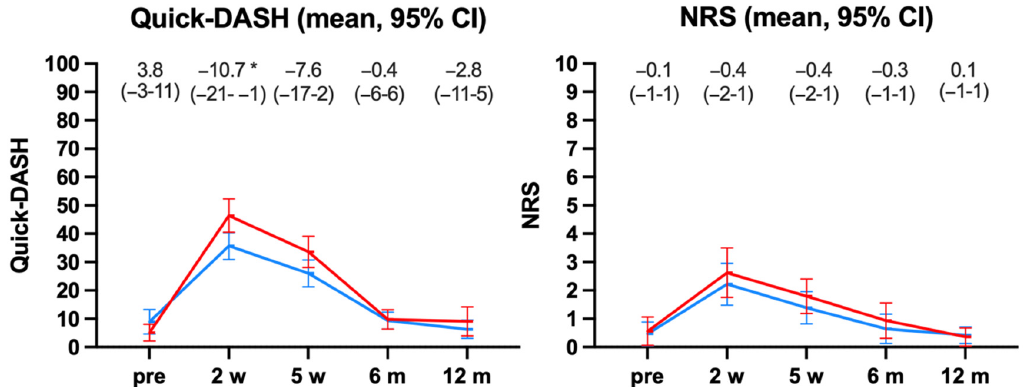
Figure 3. QuickDASH and NRS (pain) of the displaced (red) and minimally/non-displaced (blue). non-operatively treated DRFs. Mean differences (95% CI) between the groups at the different timepoints and statistical significance * p < 0.05.